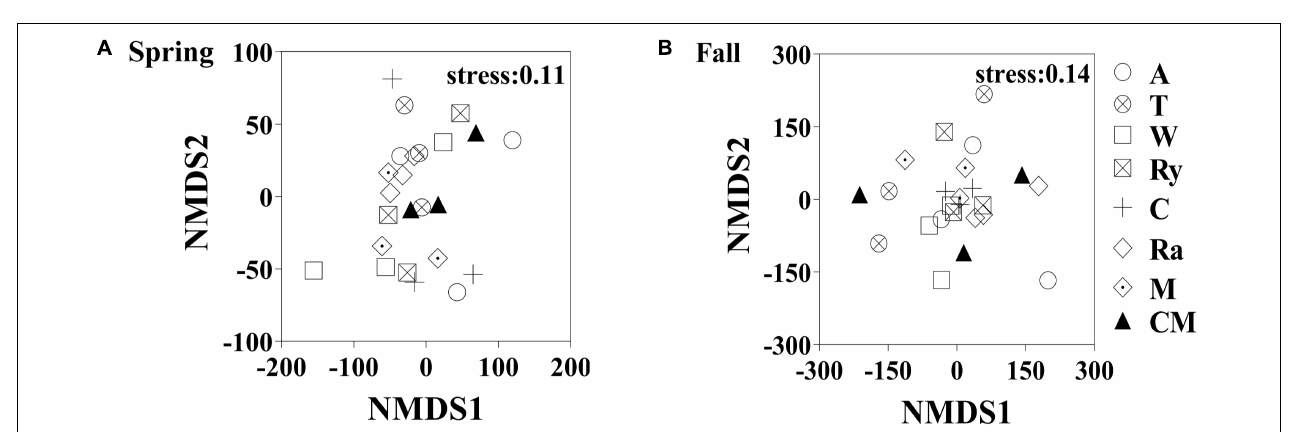
FIGURE 5 | Spearman correlation analysis of the relative abundances of dominant diazotrophic genera and soil physicochemical variables in the (A) Spring and (B) Fall cropping seasons. * p < 0.05. AK, available potassium; AP, available phosphorus; MBC, microbial biomass carbon; MBN, microbial biomass nitrogen.